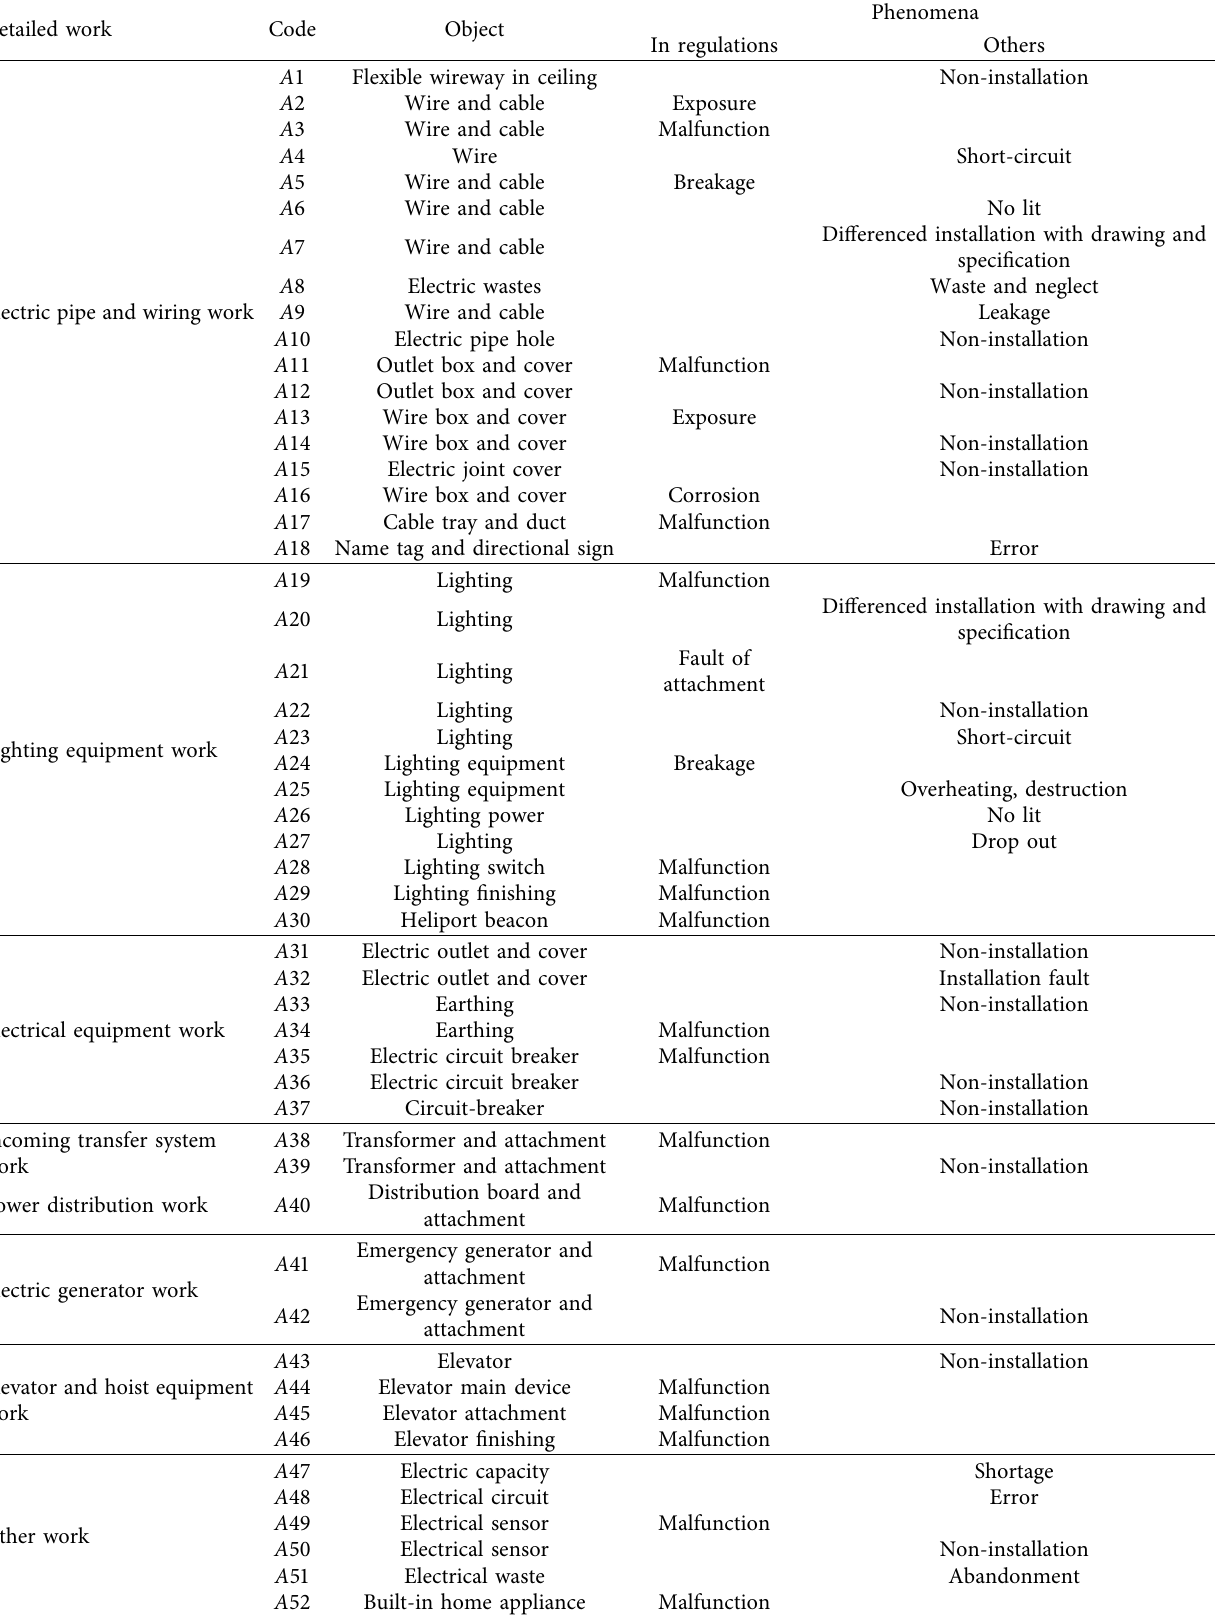
Table 2: Quality management item of index A